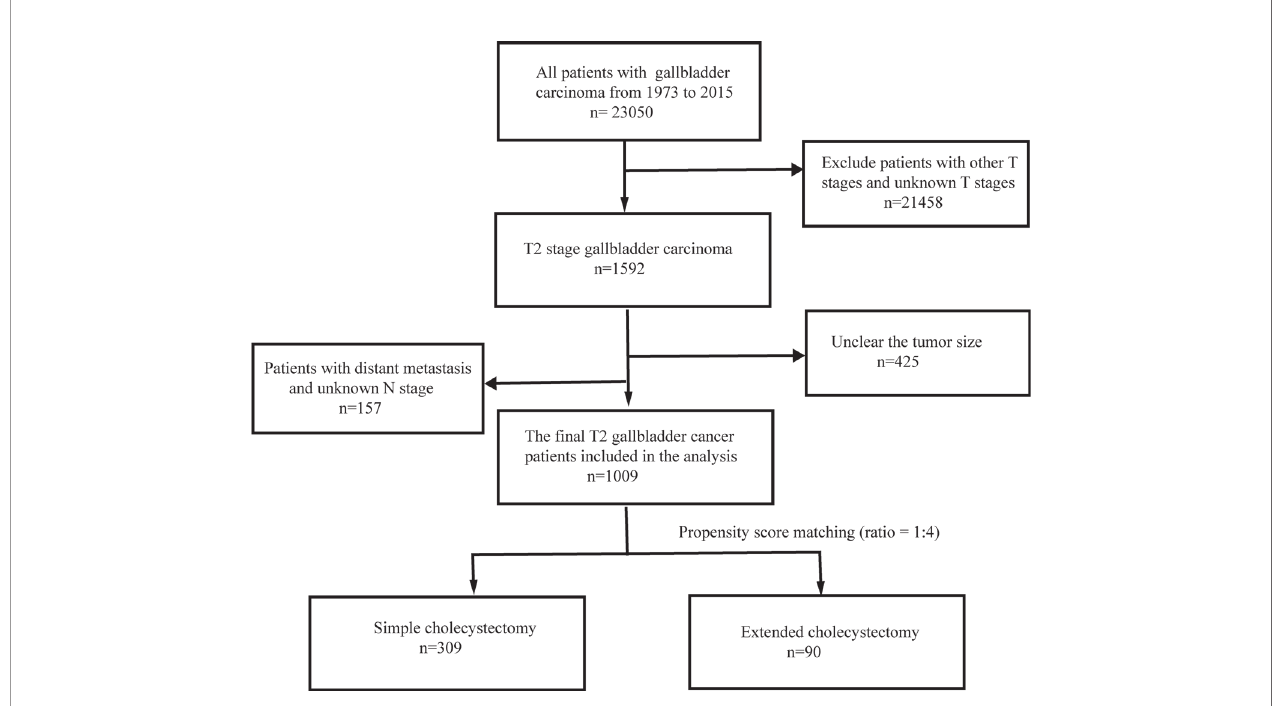
FIGURE 1 | Flow chart for identi fi cation of the study